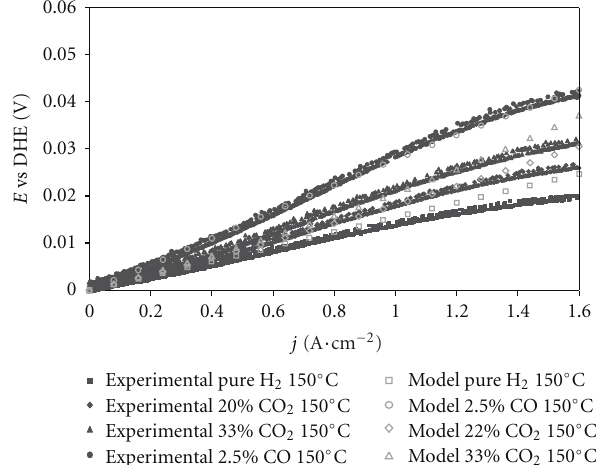
Figure 9: Experimental CO and CO 2 e ff ects on anode performance at 150 ◦ C with platinum (20% Pt/C) loading of 0.2 mg compared to the model